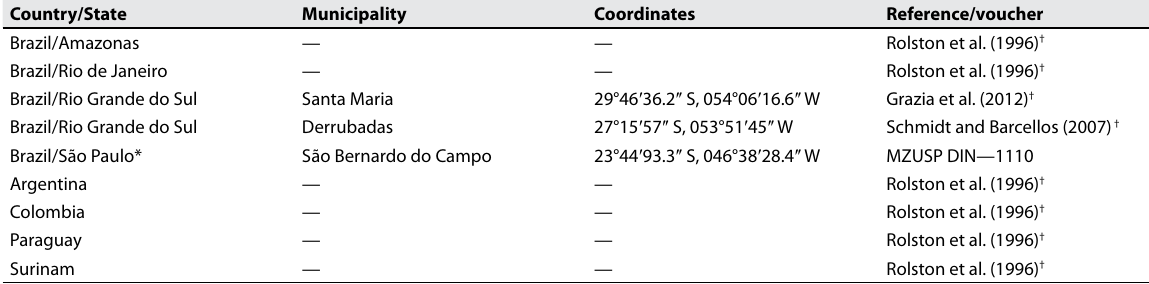
Table 1. All records of Dinidor mactabilis including the new record reported herein.